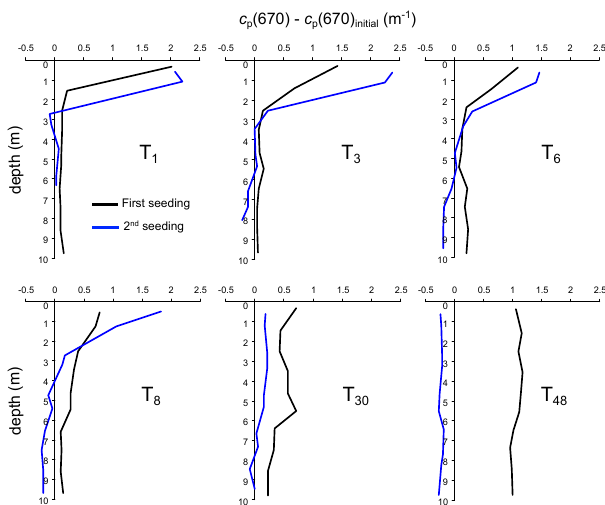
Fig. 3. The vertical profiles of 1c p (670) ( c p (670)– c p (670) initial in m − 1 ) for different times following both seedings. Negative values correspond to a decrease compared to the initial c p (670) coefficient.